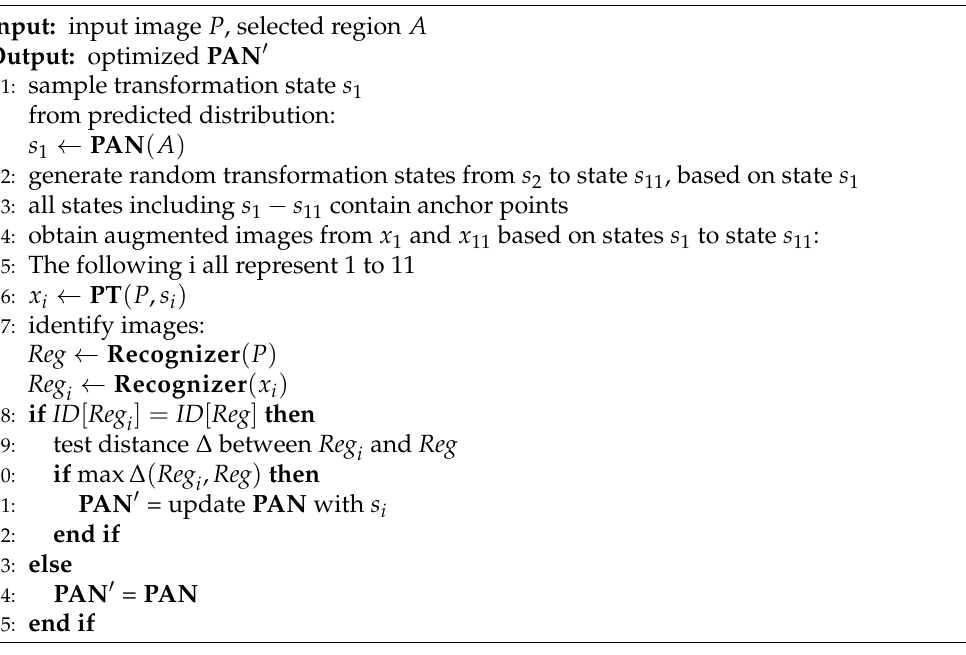
Algorithm 2 Adversarial Process of Parameter Agent Network (PAN) and